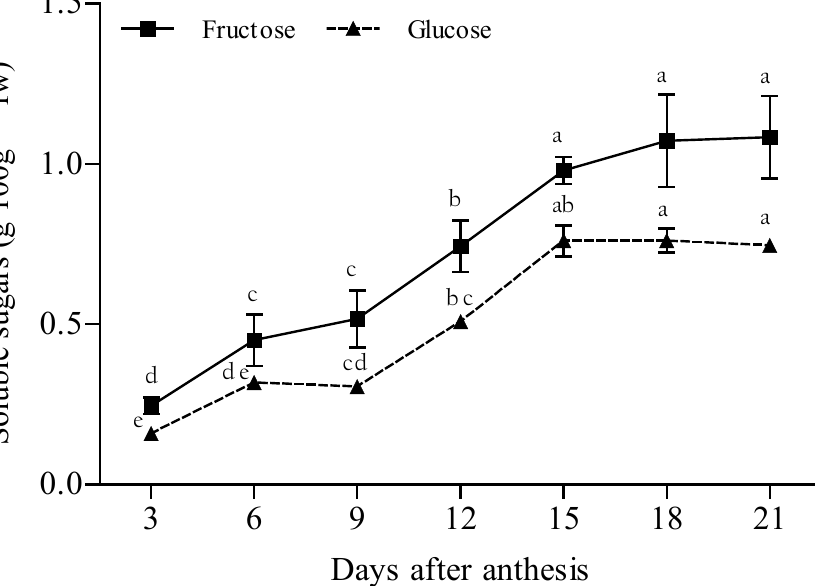
Figure 4. Accumulation of soluble sugars in fruits of chayote Sechium edule var. virens levis ( n = 3 ± standard deviation). Different letters show significant differences in the same sugar (Tukey test, α = 0.05).